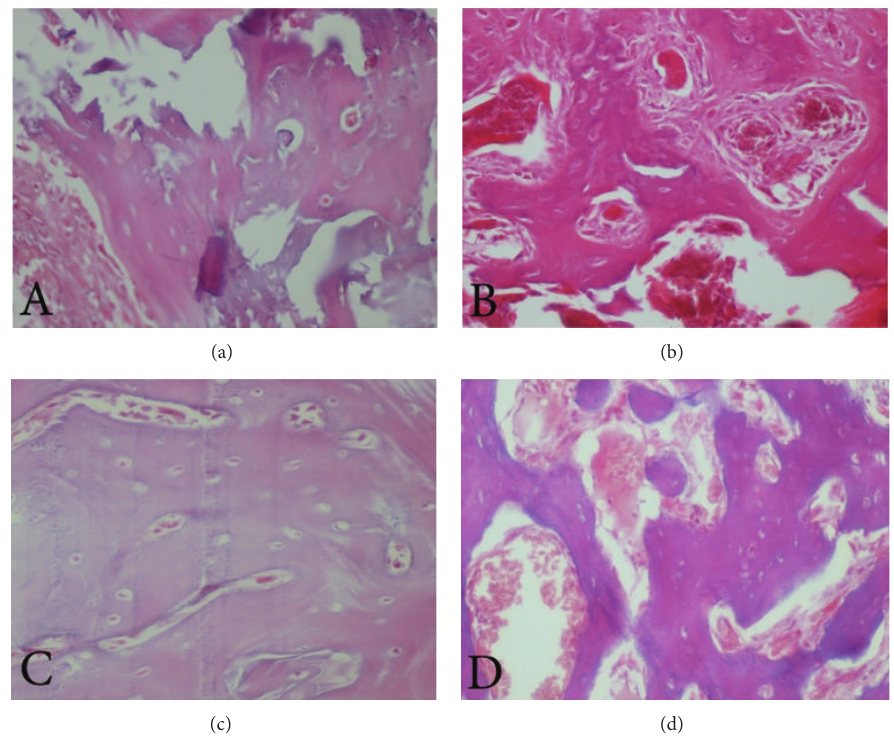
Figure 5: (a, b) Bone trabeculae on left and right tibias and (c, d) inflammation on left and right tibias on day